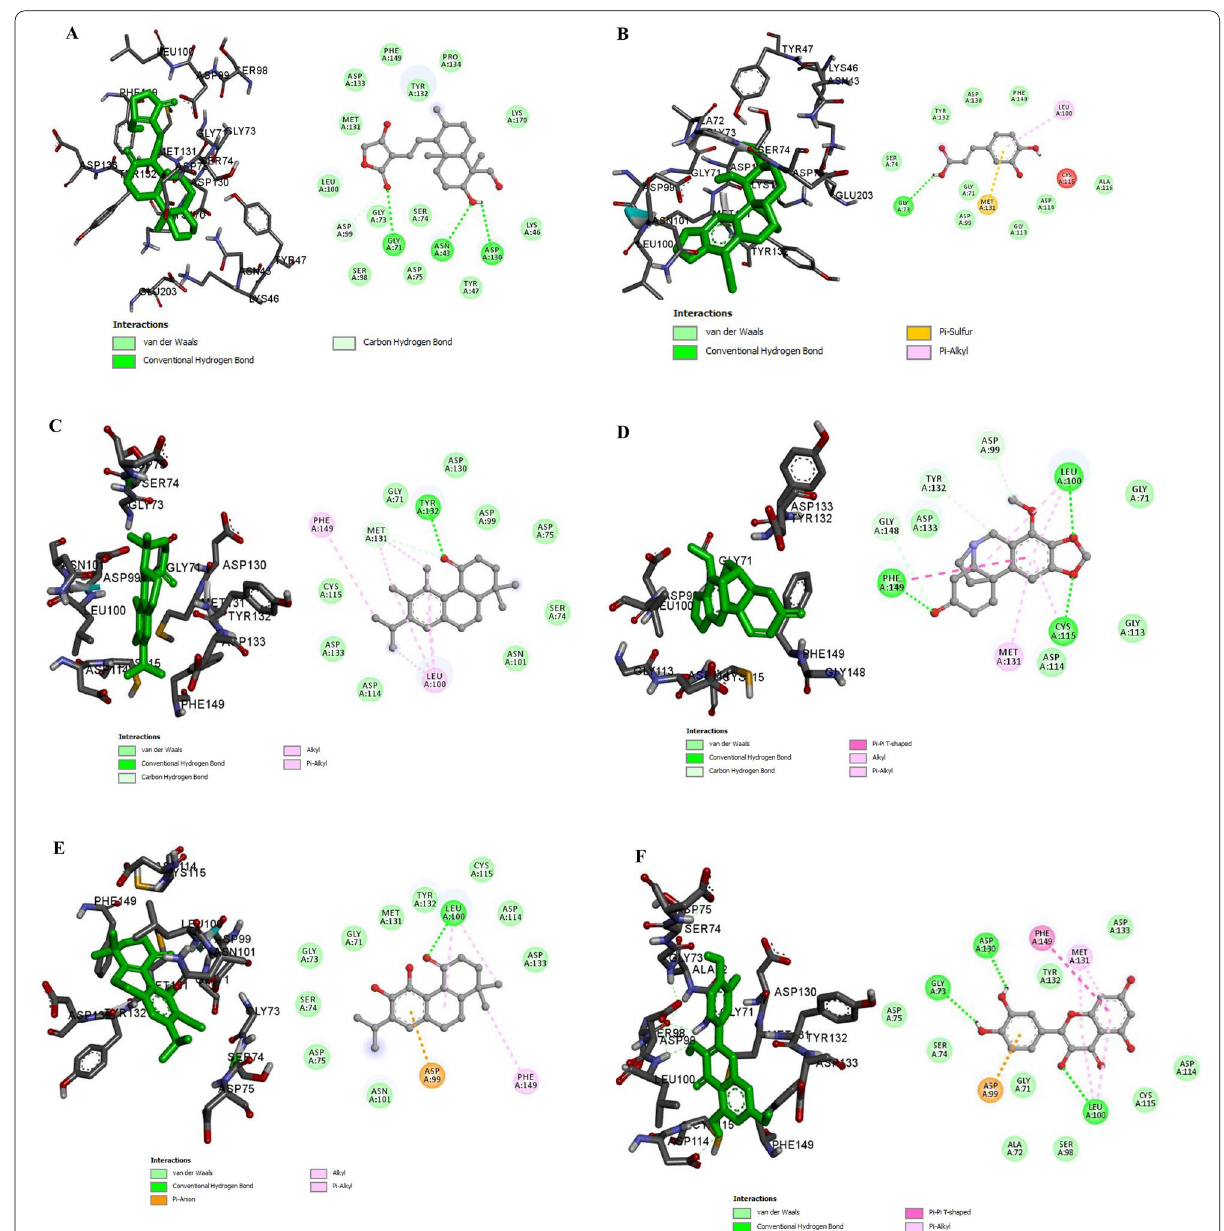
Fig. 3 2D and 3D binding mode of best 6 phytocompounds with the active site of nsp16. A Andrographolide. B Deacetylbowdensine. C 11, 12-dimethylsageone. D Oxopowelline. E Sageone. F Quercetin. From the 3D presentation, ligands are colored in green sticks while amino acid residues are in black sticks. Gray sticks and spheres represent the ligands and amino acid residues respectively in 2D